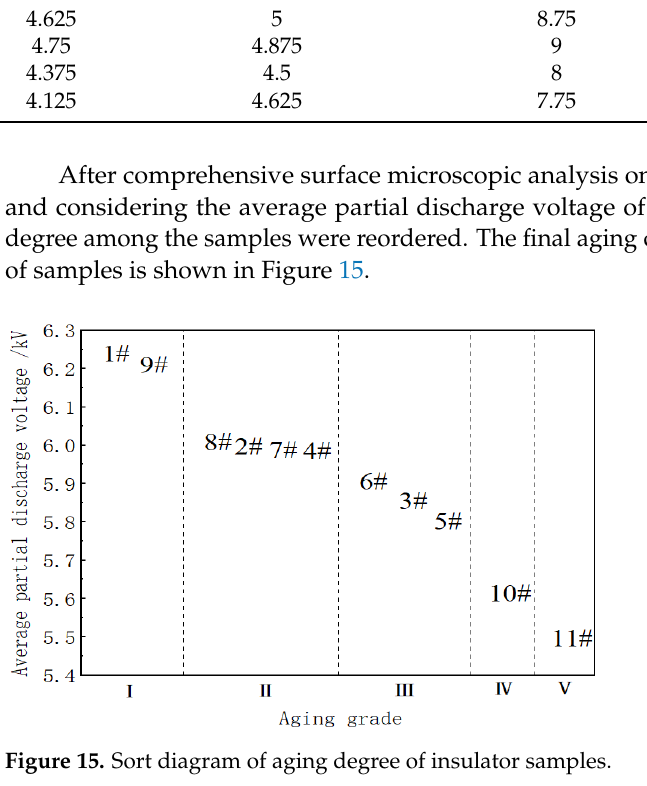
Table 1. Partial discharge voltage data of insulator slice.